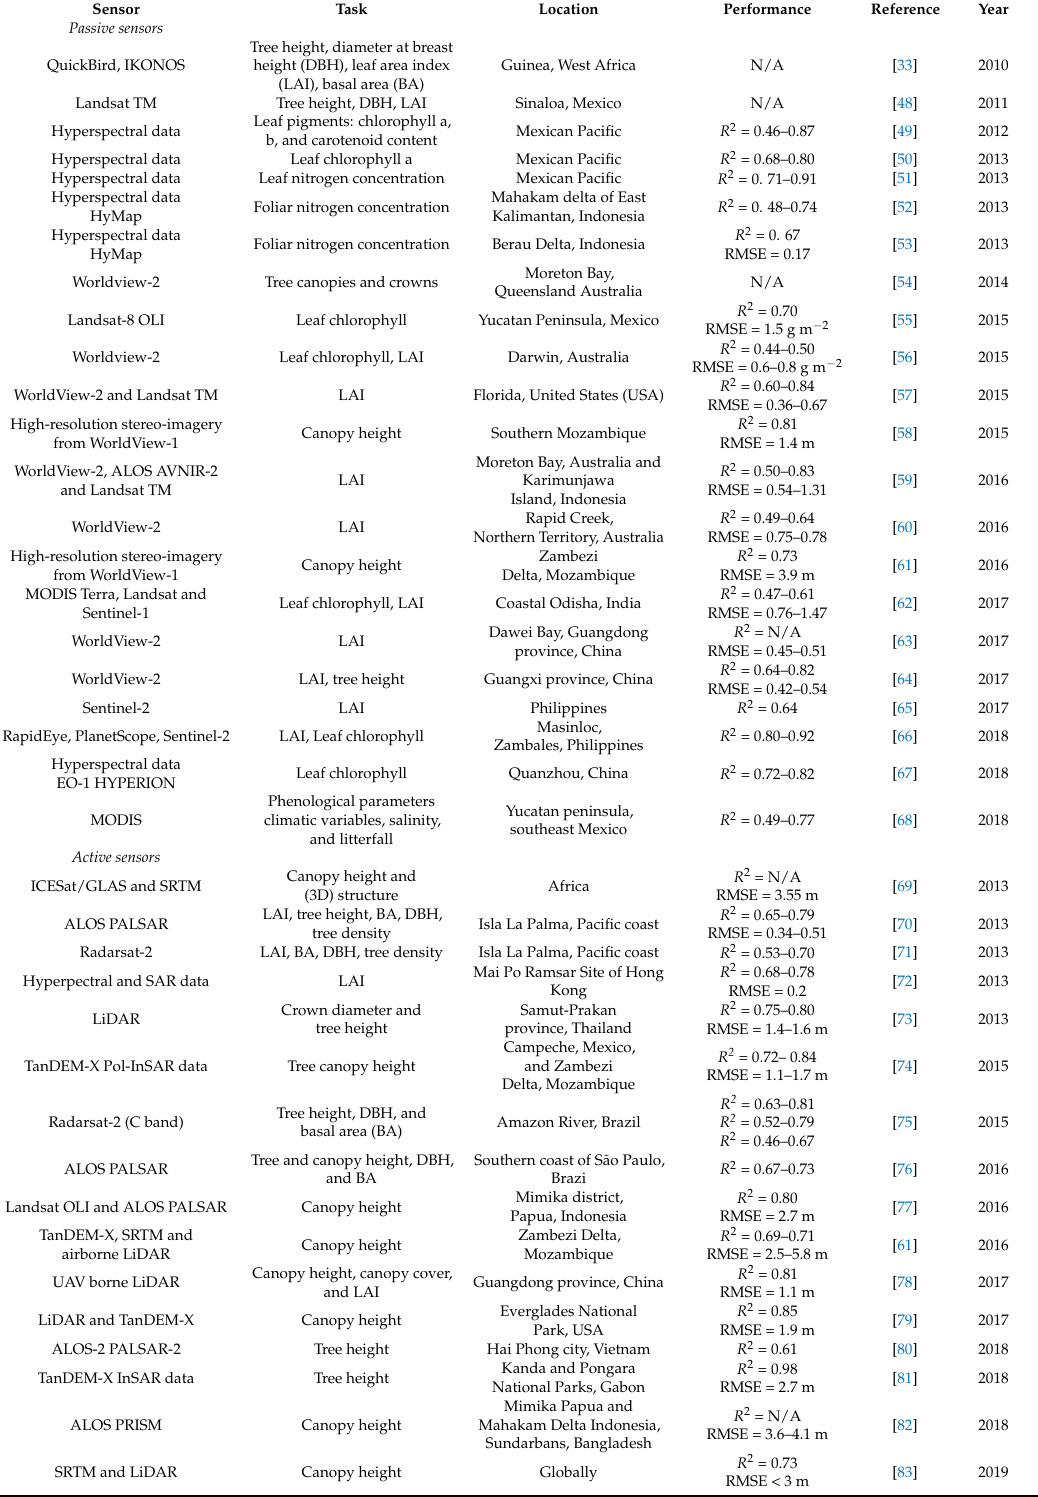
Table 3. Examples of recent studies that examined mangrove biophysical parameters using remote